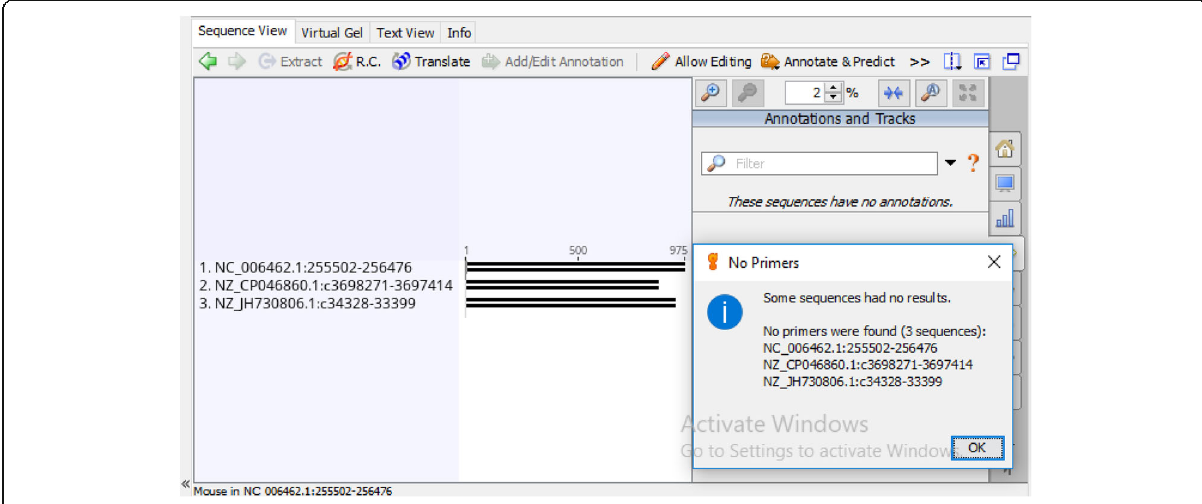
Fig. 12 In silico PCR result of authentic bacterial strains without catechol 1,2-dioxygenase (C12O)